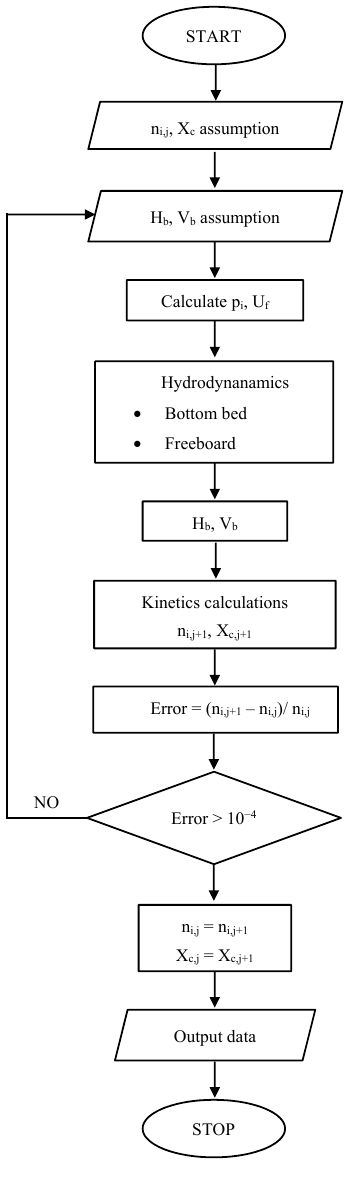
Figure 3. Simplified flow diagram of simulation calculation.